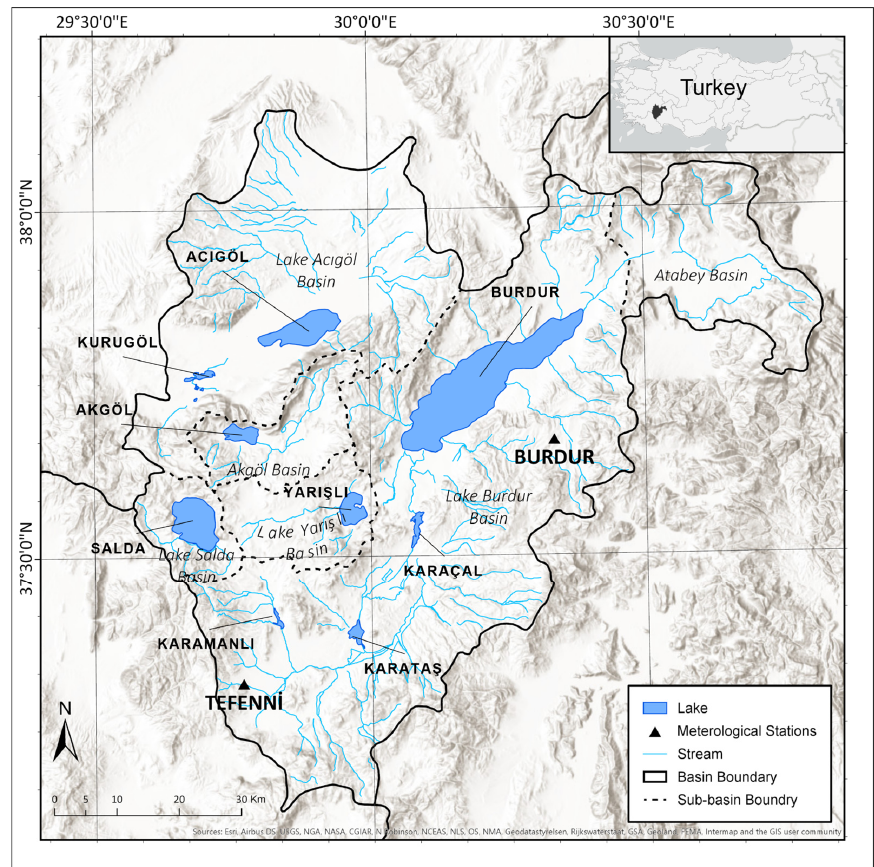
Figure 1. Burdur Closed Basin topography, sub-basins, lakes, and locations of meteorological stations.